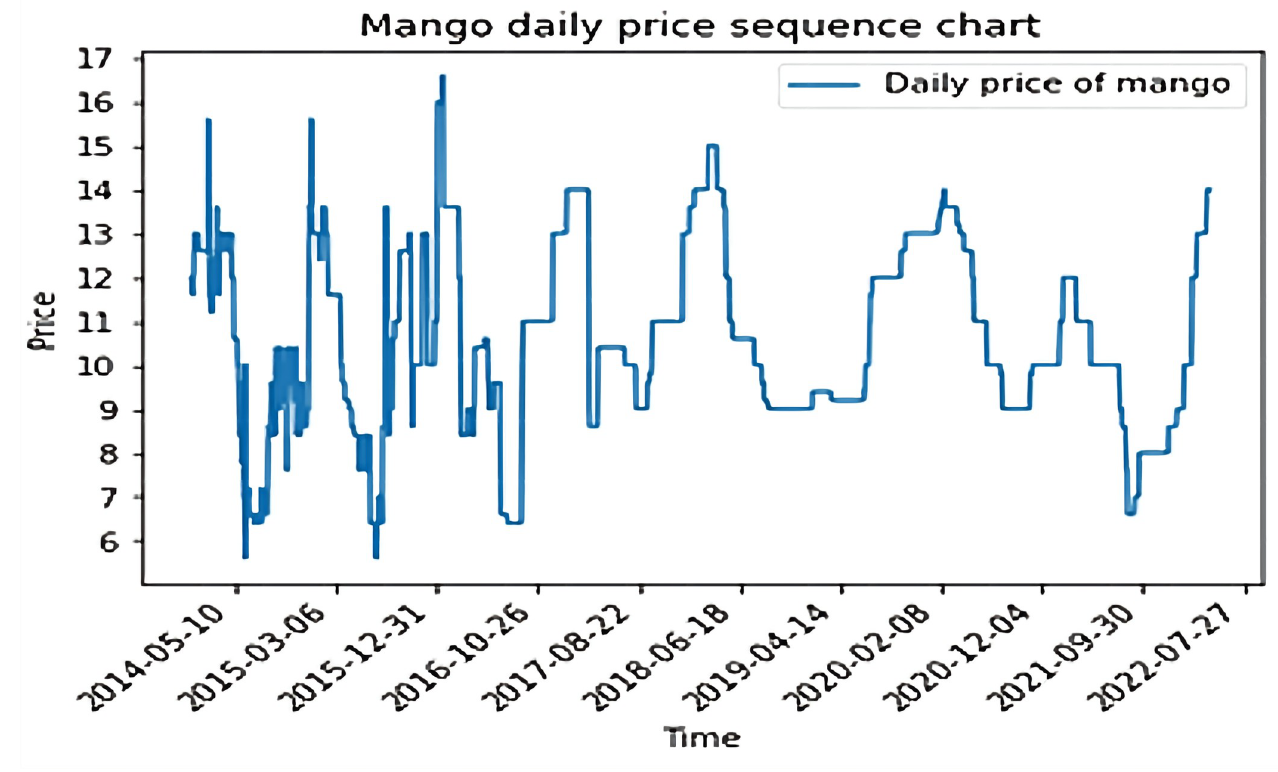
Fig 3. Daily price series of mangos from 2014-01-02 to 2022-04-18.